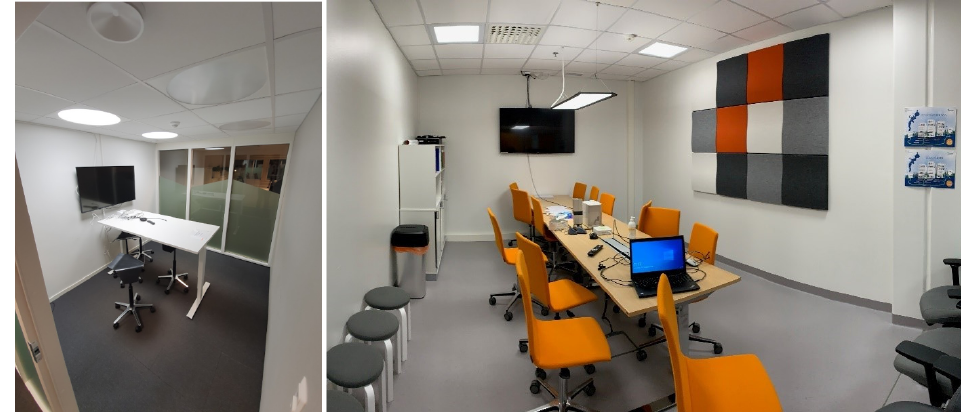
Figure 1. ( Left ): Source room. ( Right ): Target room.